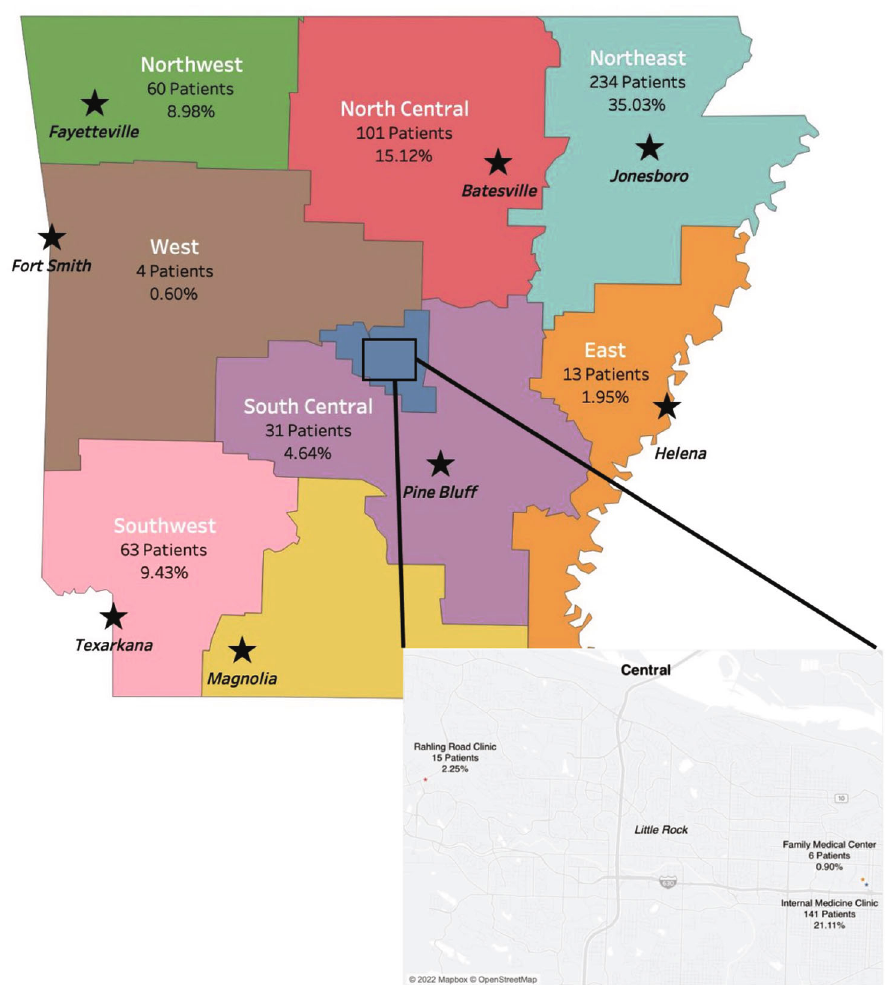
Figure 2: Arkansas state map depicting UAMS primary care clinics across the state with the number of patients screened for diabetic retinopathy at each location. The inset map depicts the three clinic sites located in the Central Arkansas